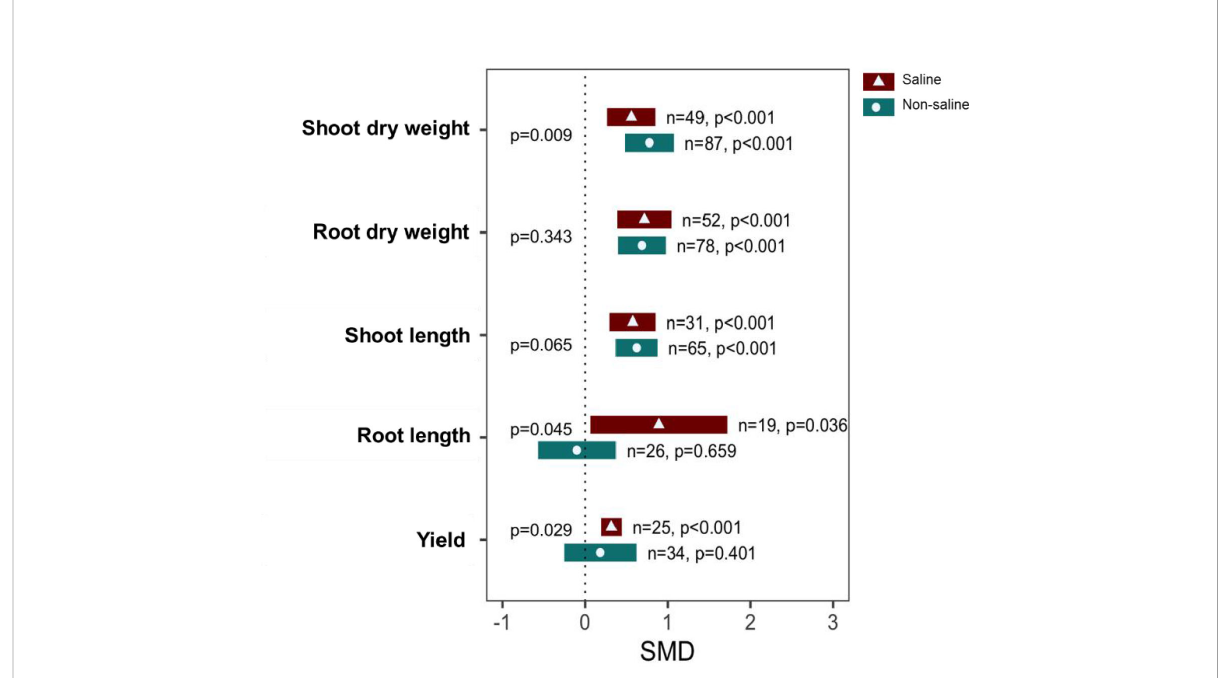
FIGURE 3 Growth responses and yield of exogenous NO-treated plants compared with those of non-NO-treated plants under non-saline and saline conditions. Error bars are effect size (SMD) means ±95% CIs. Where the CIs do not overlap the vertical dashed lines, the effect size for a parameter is signi fi cant, i.e., the growth responses of NO-treated plants were signi fi cantly different from those of non-NO-treated plants. n , the number of studies included in the meta-analysis; p , the signi fi cance level of